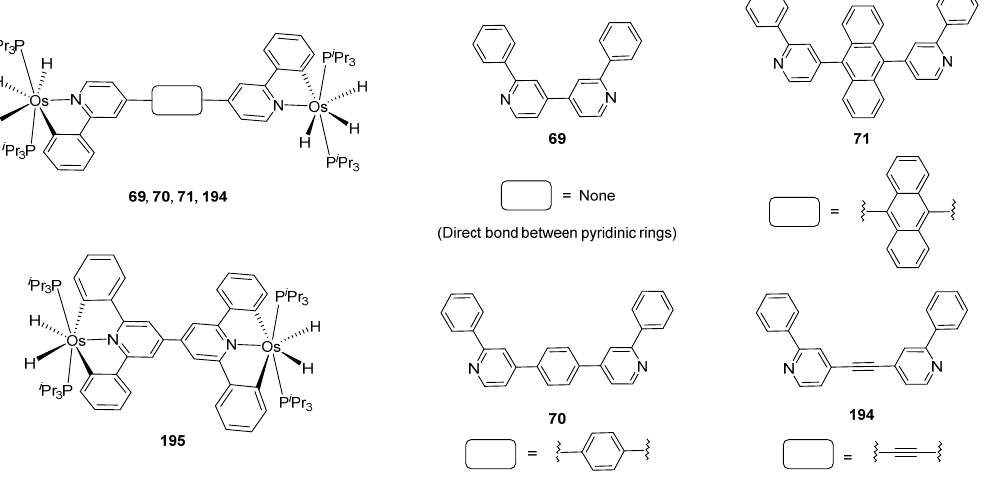
Figure 49. Bimetallic luminescent complexes.